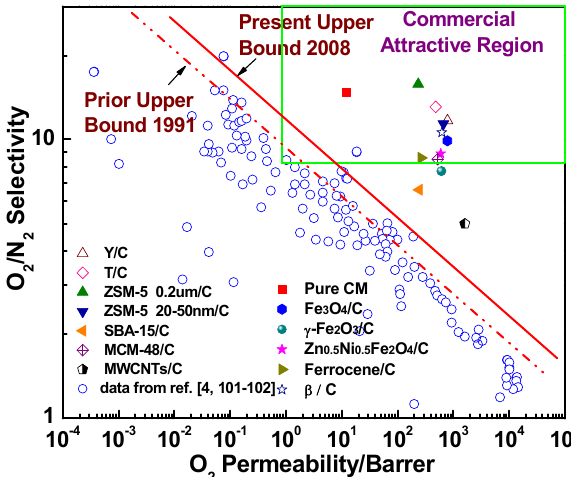
Figure 24. Permeability (O 2 ) and selectivity (O 2 /N 2 ) of hybrid CMS membranes.